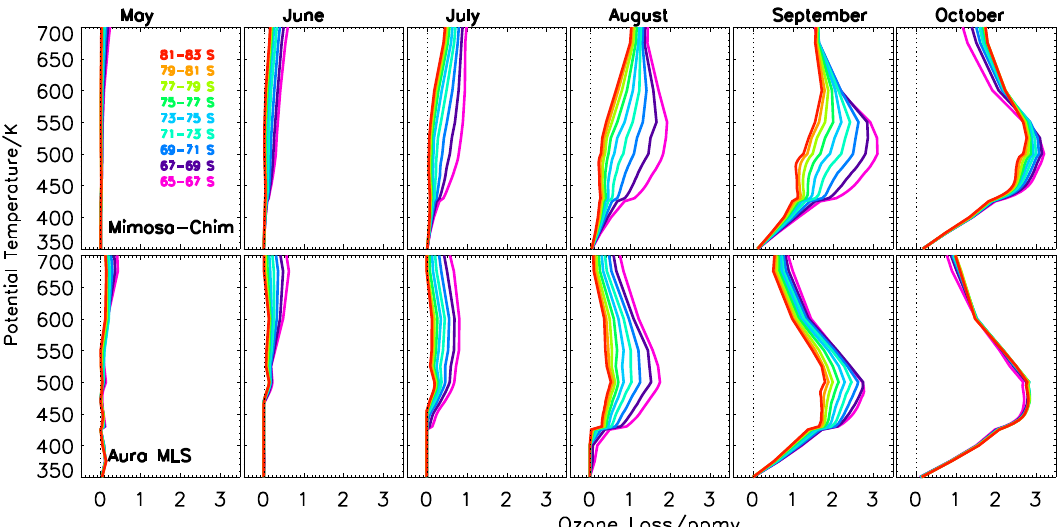
Figure 1. The 10-year (2004–2013) average monthly mean ozone loss estimated at different equivalent latitude (EqL) bins (of 2 ◦ ) from 65 to 83 ◦ S EqL from the MIMOSA–CHIM simulations and MLS measurements. The model results are interpolated with respect to the time and location of the MLS measurements inside the vortex and then averaged for the corresponding day. The y axis represents potential temperature in K. The black dotted lines represent